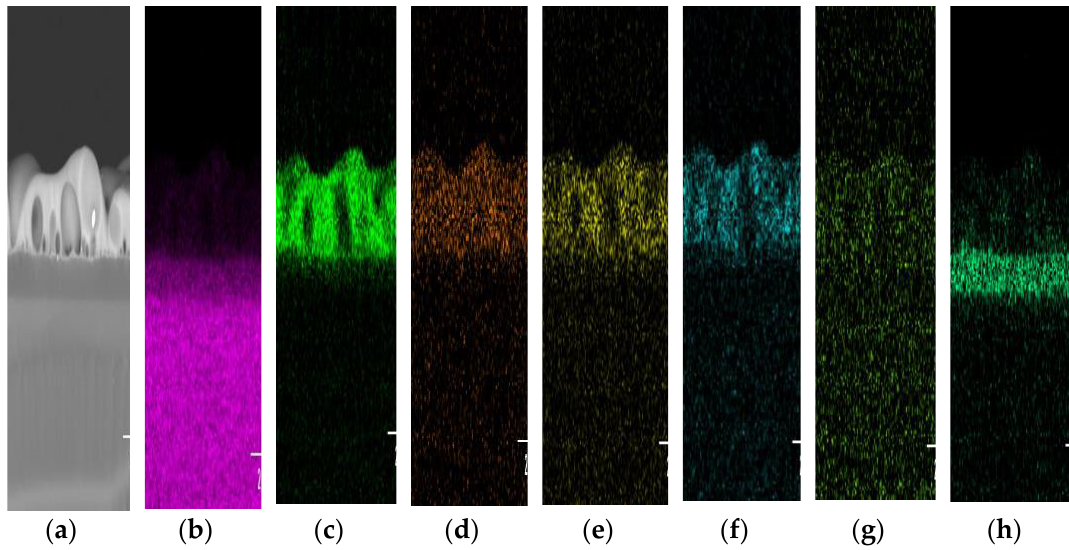
Figure 12. Area scan measured by EDX-SEM for sample K600 with ( a ) the area being measured. The distribution of species presented is that of ( b ) silicon, ( c ) oxygen, ( d ) tellurium, ( e ) sodium, ( f ) zinc, ( g ) erbium and ( h ) nitrogen.